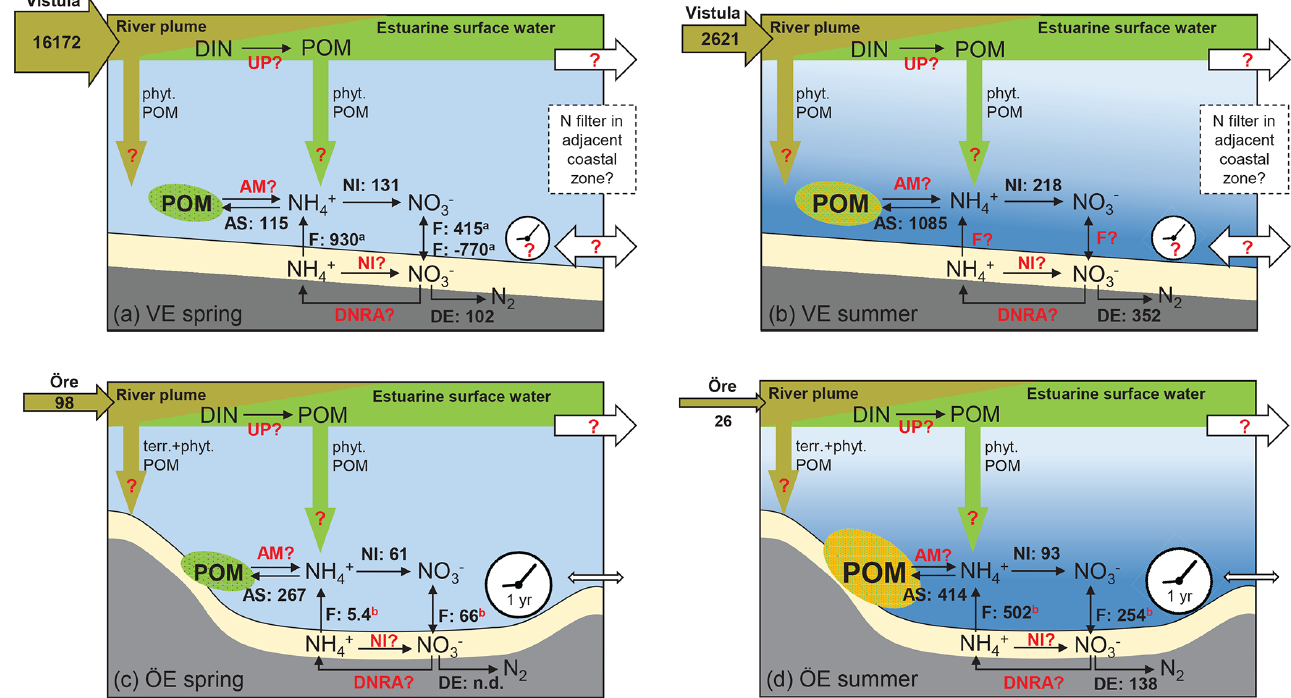
Figure 7. Schematic of the N filter and its driving factors in the Vistula Estuary (a, b) and Öre Estuary (c, d) in spring and summer. The riverine total N loads are given in tonnes per month in the horizontal brown arrows. The process rates of nitrification (NI), ammonium assimilation (AS), and denitrification (DE), determined in this study, are given in micromoles per square metre per day (volumetric nitrifica- tion and ammonium assimilation rates were integrated over the vertical BBL extent to derive areal rates). Benthic POM is fresh but low in concentration in both estuaries in spring (green ellipse), while it is higher in concentration in summer and more degraded in the Öre Estuary (yellow ellipse). Fluxes of NH + and NO − ( F ) in the Vistula Estuary are from Thoms et al. (2018; in situ incubations, a ), and those in the 4 3 Öre Estuary are from Nedwell et al. (1983; core incubations, not in situ, b ). Other microbial N retention process rates such as N uptake in the surface (UP), benthic ammonification (AM), nitrification (NI), and dissimilatory reduction to ammonia (DNRA) in the sediment are still unknown (marked in red). Fluxes from the Öre Estuary are also marked red, since these fluxes were not measured under in situ conditions; newly measured in situ fluxes are needed for a better evaluation. Also, sedimentation rates of terrestrial and phytoplankton-derived POM from the river (brown arrow) or from the estuarine surface water (green arrow) as well as transport rates (white arrows) and the particle (VE) and nutrient (VE, ÖE) residence time (white clock) are unknown for these two estuaries (red question mark). The conceptual idea of the N filter in the two estuaries is that riverine DIN is supplied to the benthic system indirectly, via POM build-up and sedimentation, which uncouples the peak river N load in spring from enhanced N turnover in the benthic system in summer. In the Öre Estuary, the limited bottom water exchange and hence the long particle residence time results in a high efficiency of the estuarine N filter (see Sect. 4.3). In the Vistula Estuary, the unrestricted bottom topography may lead to transport of DIN and POM with the prevailing alongshore currents and thus to a potential extension of the coastal filter function over a larger area and a longer timescale (see Sect. 4.3). Please note that this figure is not intended to present a closed N budget for these coastal